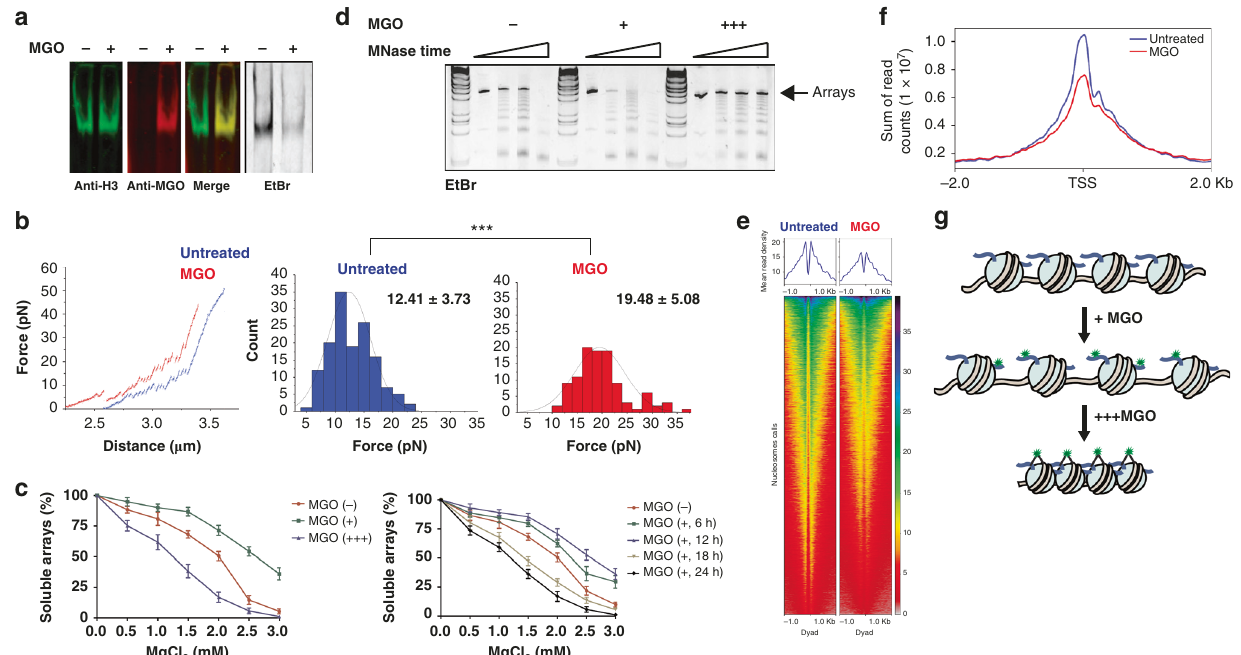
Fig. 4 Histone glycation changes chromatin architecture in vitro and in cellulo. a Reconstituted nucleosomal 12mer arrays were incubated with 1mM MGO for 12h and analyzed by APAGE (agarose polyacrylamide native gel), either with EtBr or western blot utilizing the indicated antibodies to show the stability of the arrays upon MGO treatment. b Nucleosomal arrays were treated with 100 mM MGO (corresponding to 1:30 sites:MGO stoichiometry) for 12h at 4°C. Left: Representative single-molecule unfolding trajectories of MGO-treated (red) and untreated (blue) array obtained by an optical tweezer experiment. Right: Histograms of forces required to unravel each nucleosome in the MGO-treated nucleosomal array (red) and untreated (blue) array. Statistical analysis was based on sampling more than 50 single-molecule data and performing a t test. c Left: magnesium compaction assay of nucleosomal arrays treated with different concentrations of MGO. ( + ) 10mM (corresponding to 1:3 sites:MGO stoichiometry); ( +++ ) 100mM MGO (corresponding to 1:30 sites:MGO stoichiometry). Right: array treated with low MGO concentration for different time points. ( + ) 2mM MGO (corresponding to 1:0.6 sites:MGO stoichiometry). Error bars represent standard deviation from three different experiments. d MNase digestion of nucleosomal arrays treated with increasing amounts of MGO. Samples were separated on a native gel and stained with EtBr. e ATAC-seq performed on 293T cells either untreated or treated with 0.5mM MGO for 12h. Heatmaps showing the density of mapped ATAC-seq reads at consensus nucleosome peaks and 1000bp up and downstream from the nucleosome dyad. Line graphs above show the same data as the mean read depth over all nucleosome peaks. f Line graph of the sum of ATAC-seq reads over RefSeq